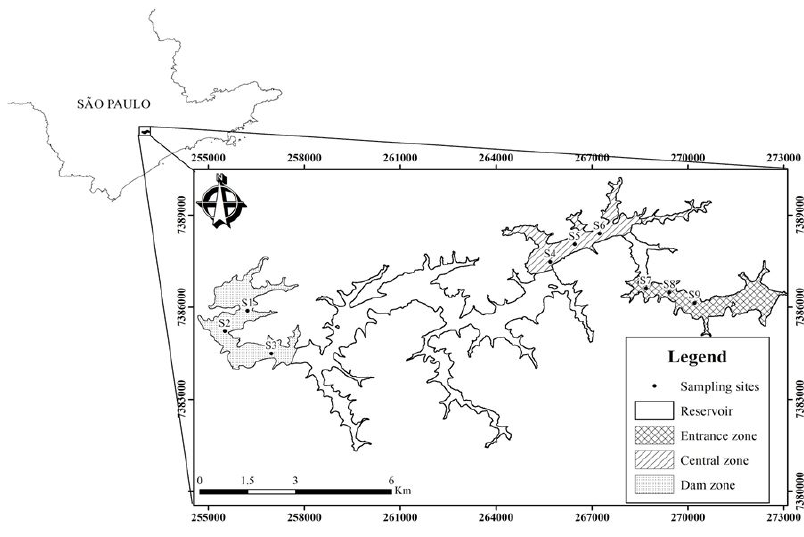
Figure 1. Itupararanga reservoir location and sampling stations (S1-S9). The first image represents the map of the state of São Paulo, including the city of Sorocaba, where the reservoir is located. The entire length of the Itupararanga reservoir is highlighted, indicating the stations where the sediment collection was